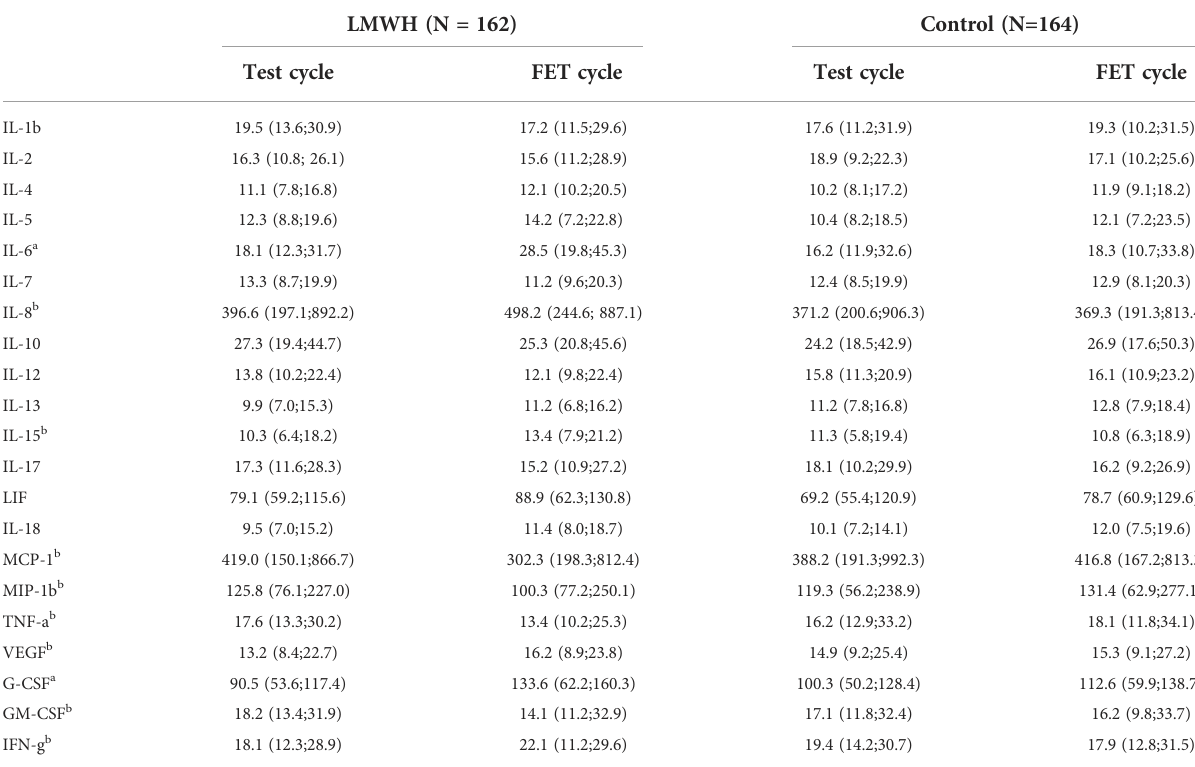
TABLE 3 Table III. Comparison of uterine cytokine concentrations in endometrial secretions between LMWH and control groups. Cytokine concentrations (pg/mg total